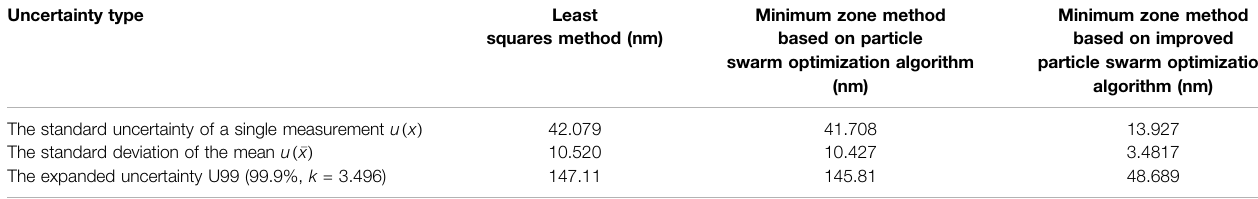
TABLE 4 | Two algorithms for evaluating the uncertainty of fl atness error of the SHS sample of 10 × 10 μ m. Uncertainty